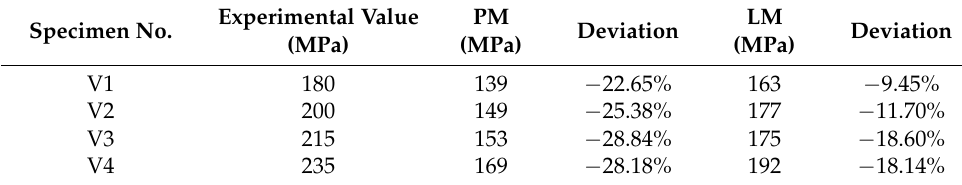
Figure 8. Results from finite element analysis (FEA). ( a ) Stress distribution near the root of the notch along the direction perpendicular to the applied load ( Y -axis); ( b ) relationship between the element size and stress at different locations. Table 3. Comparing the predicted values of PM and LM with the fatigue experimental results. Specimen